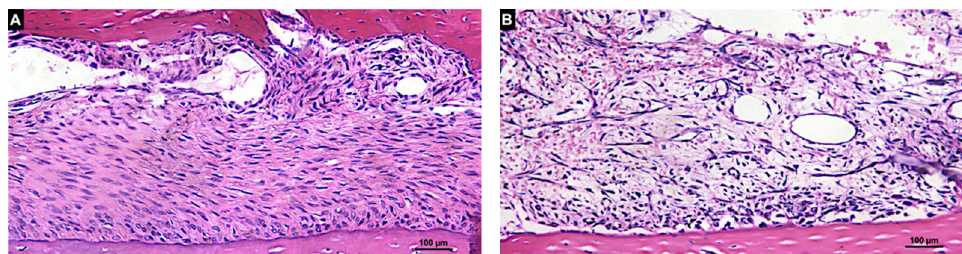
Figure 7. Histologic photomicrography of the interface between the recipient bed and graft (Base region) in the autogenous ( A ) and xenogenous ( B ) grafts after 7 days of healing. A provisional matrix rich in fibroblast-like cells was observed for both groups. Hematoxylin and eosin stain; magnification 200×.